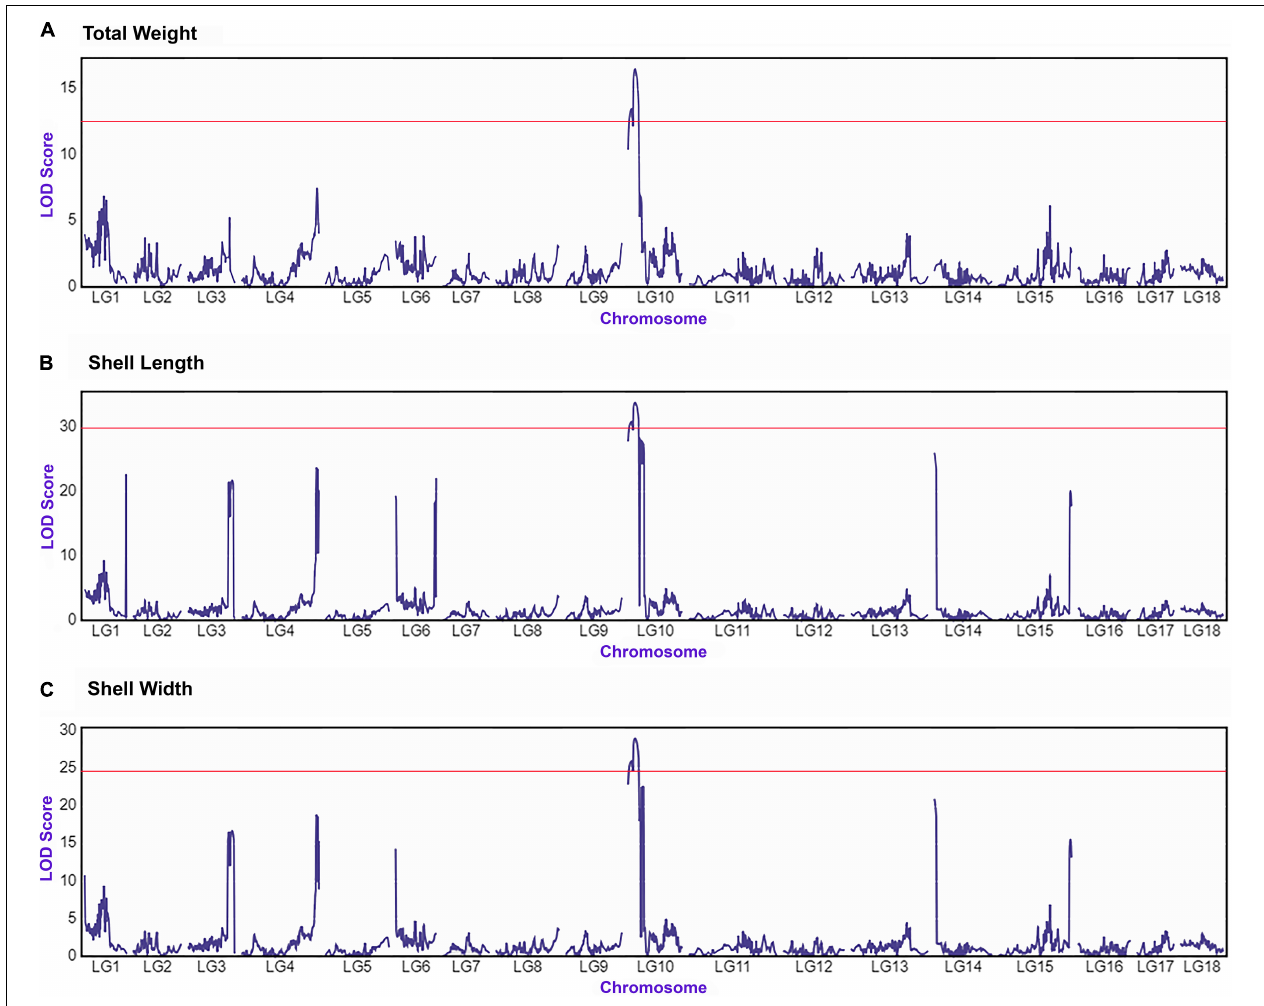
FIGURE 3 | QTL mapping and LOD profile of growth-related traits total weight (A) , shell length (B) and shell width (C) of Pacific abalone among 18 linkage groups. The red solid line indicates chromosome-wide significance thresholds.